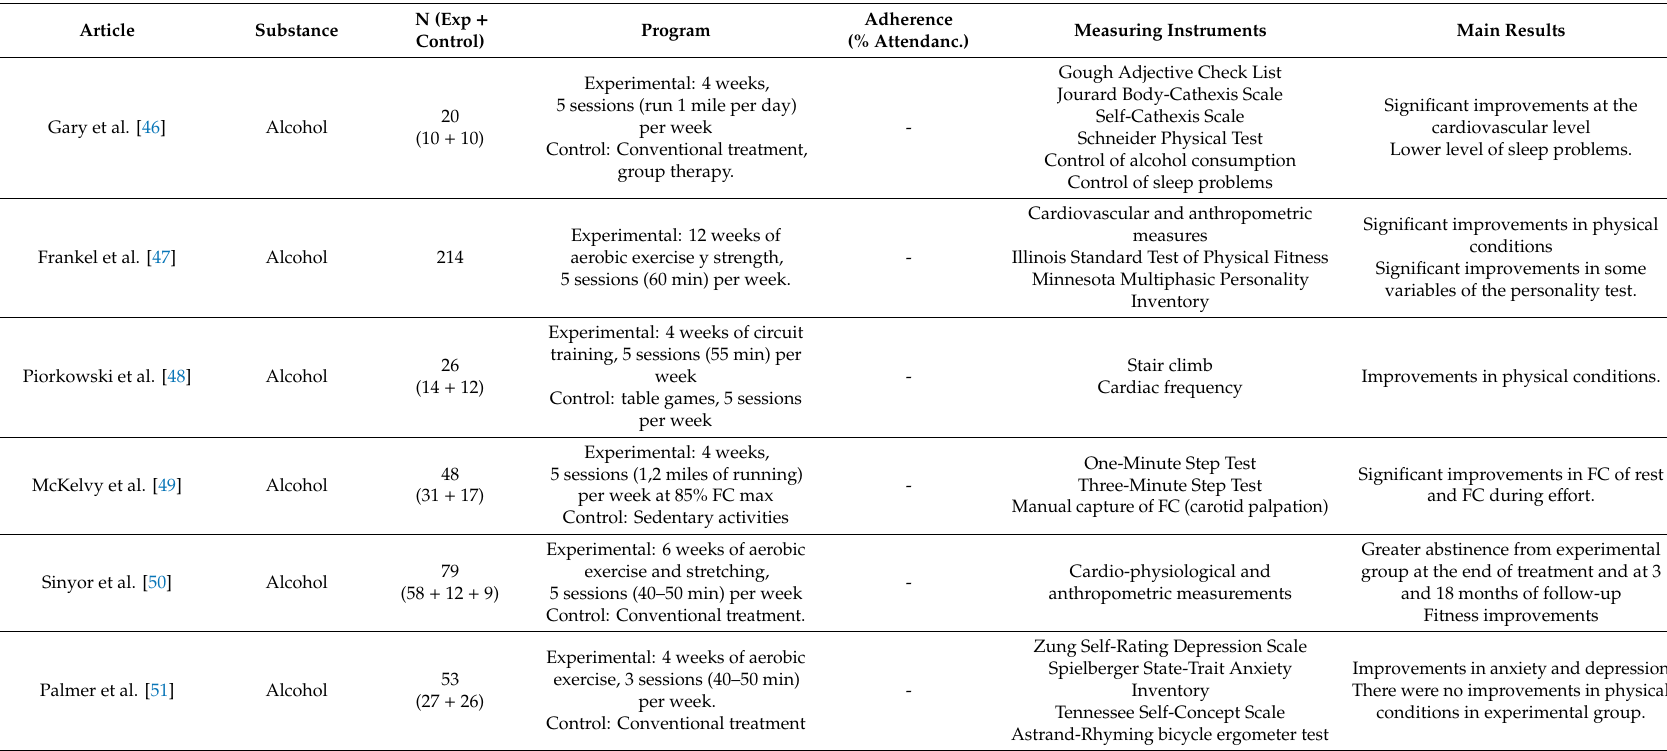
Table 3. Studies that measure the e ff ect of long-term exercise on alcohol use disorder (AUD)